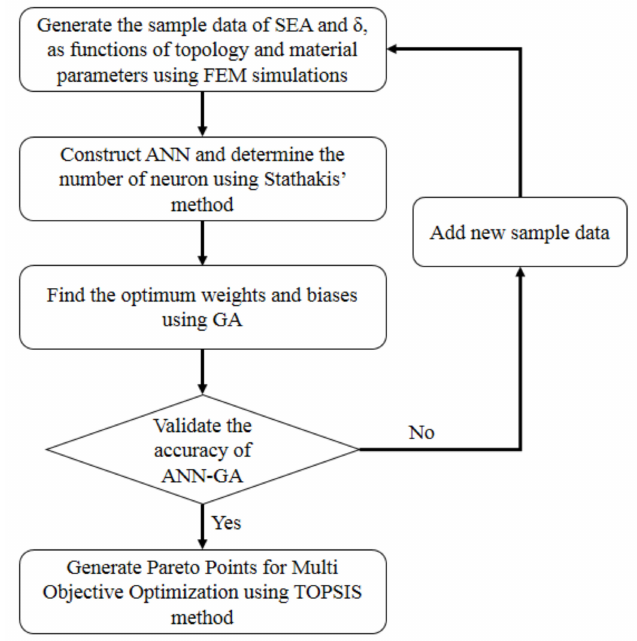
Figure 5. Flowchart of the optimization process.